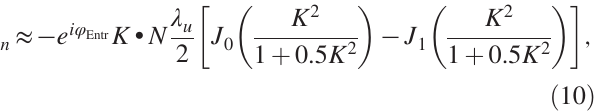
of two undulators. The length of A n